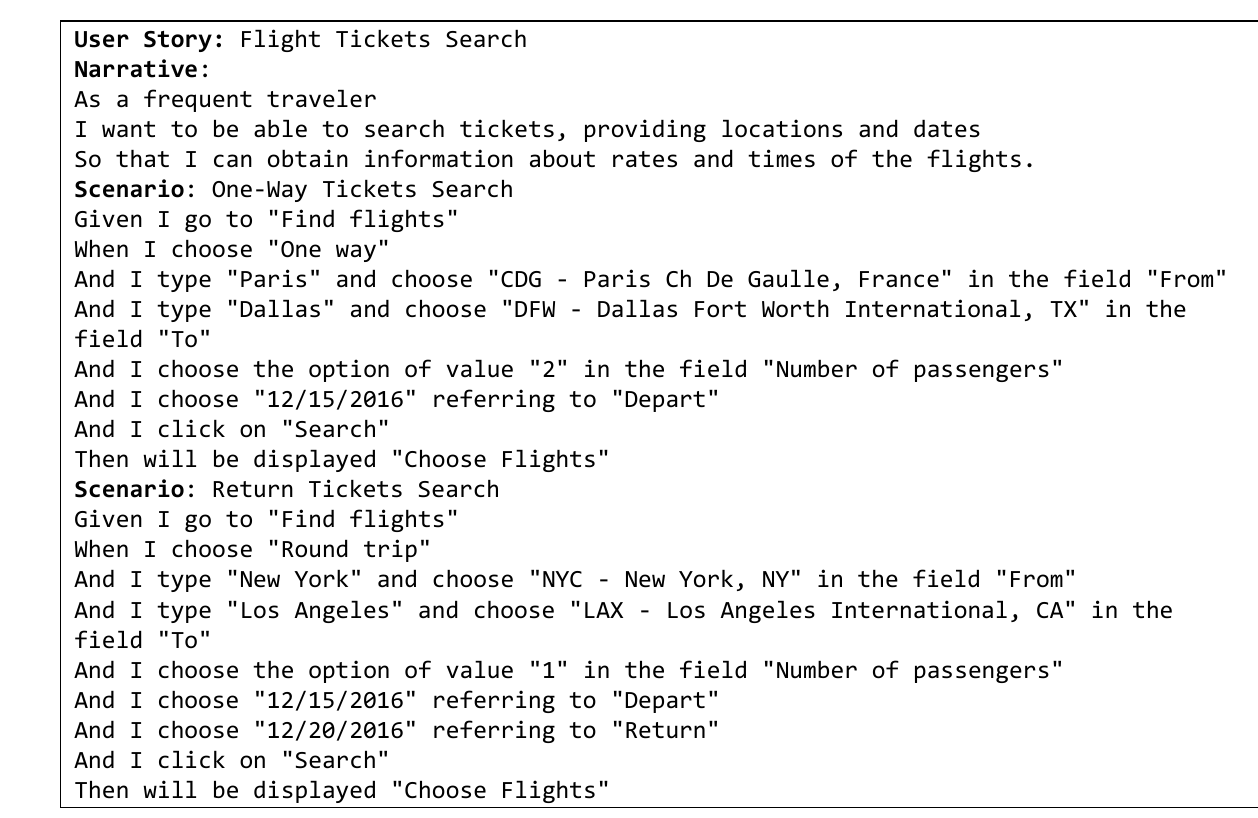
Figure 9. Conceptual Model for testable requirements